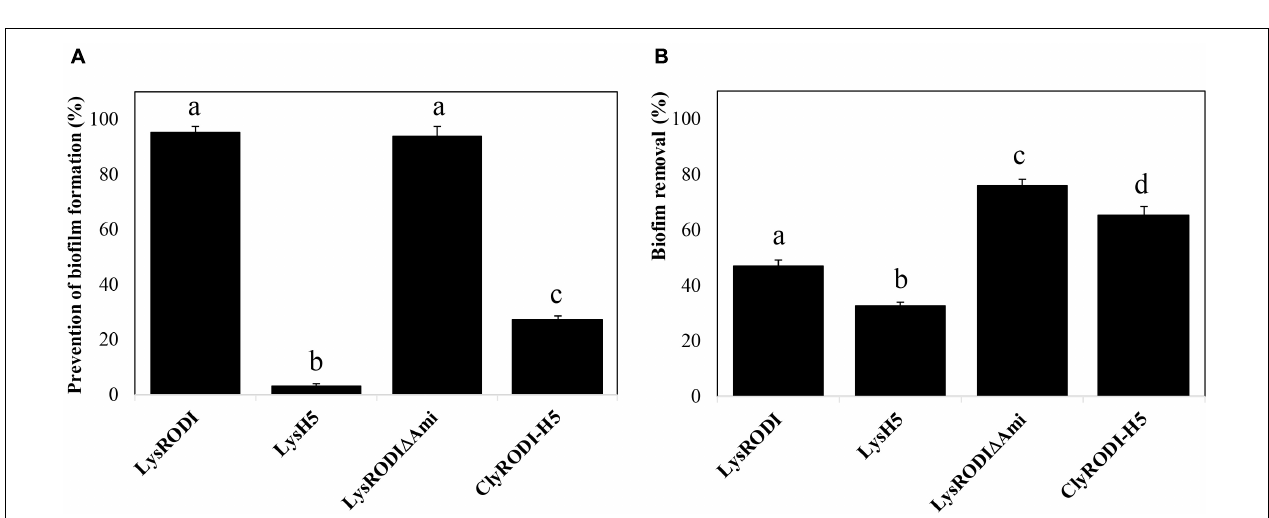
FIGURE 2 | Antibiofilm activity of different engineered proteins against S. aureus 15981 biofilms. (A) Biofilm growth inhibition in the presence of 0.15 µ M of the tested proteins. (B) Removal of 8-h S. aureus 15981 biofilms after addition of 1.5 µ M of the tested proteins and further incubation at 37 ◦ C for 3 h. Bars represent the means ± SDs of six replicates. Bars having distinct lower case letters are statistically different ( p < 0.05) from each other according to the ANOVA and SLK post hoc comparison test. The percentage of biofilm removal was calculated by crystal violet staining after the